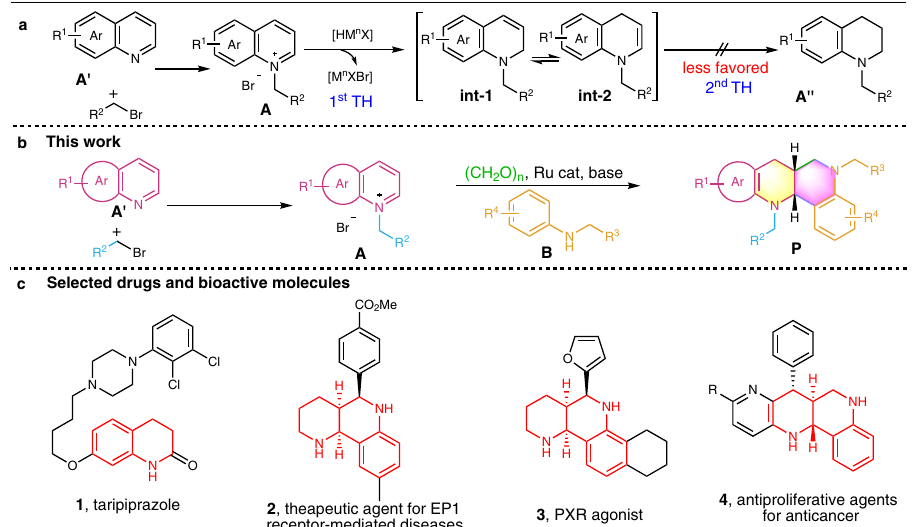
Fig. 1 Diastereoselective construction of functional polycyclic N-heterocycles by hydride transfer-initiated intermolecular annulation of the azaarenes. a The formation of N-alkyl enamine int-2 . b ruthenium-catalyzed dearomative annulation reaction of azaarenium salts A with aniline derivatives B and paraformaldehyde. c Selected drugs and bioactive molecules.